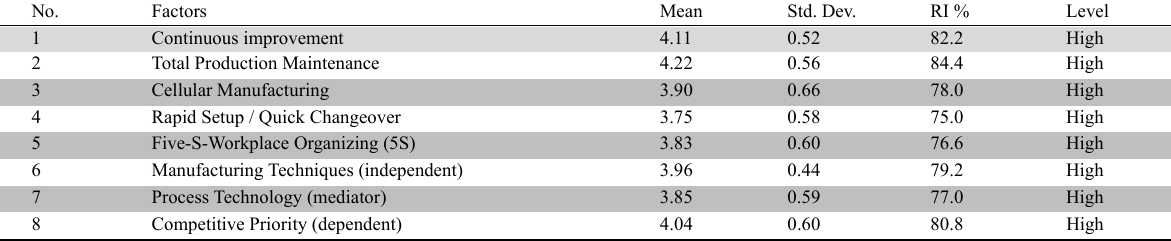
Table 2 indicates the discriminant validity results. This type of validity assumes that the variable correlates with reasonable degree. The results indicated that the greatest inter correlation value was detected between Five-S and Manufacturing Tech- niques which was the mediator variable (0.803). This correlation value may be justified as the 5 -s is one of the components (factors) that compose the independent variable (Manufacturing Techniques). Another important measure for discriminant validity is the square root of the (AVE) presented in bold diagonally. This indicator assumes that its value will be greater than the other inter correlations with the other variables. Clearly the values tell that the discriminate validity has been satisfied. Mean, standard deviations and relative importance index RI No.